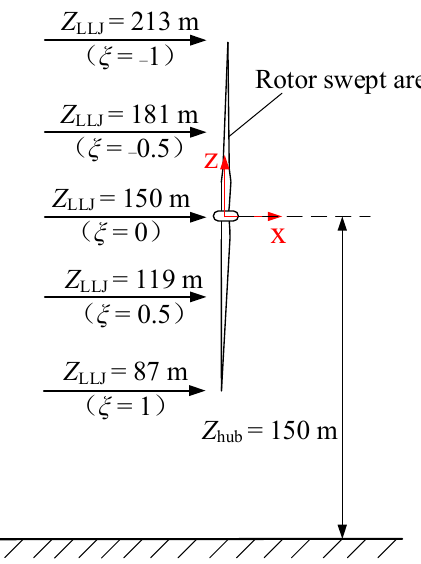
Figure 6. Schematic of the relative positions of the LLJ height and hub height. The arrows indicate the positions of the LLJ height.